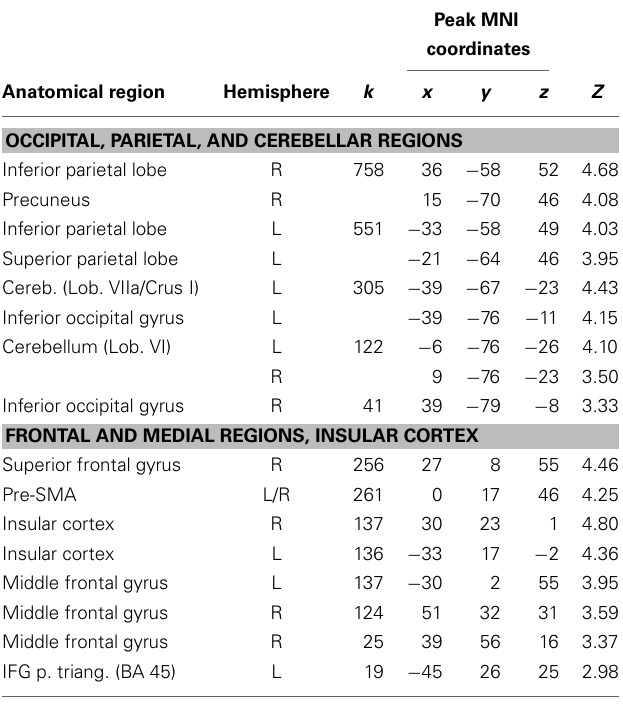
Table 3 | Peak voxels of brain areas that covary negatively with the degree of prediction during sensorimotor synchronization.